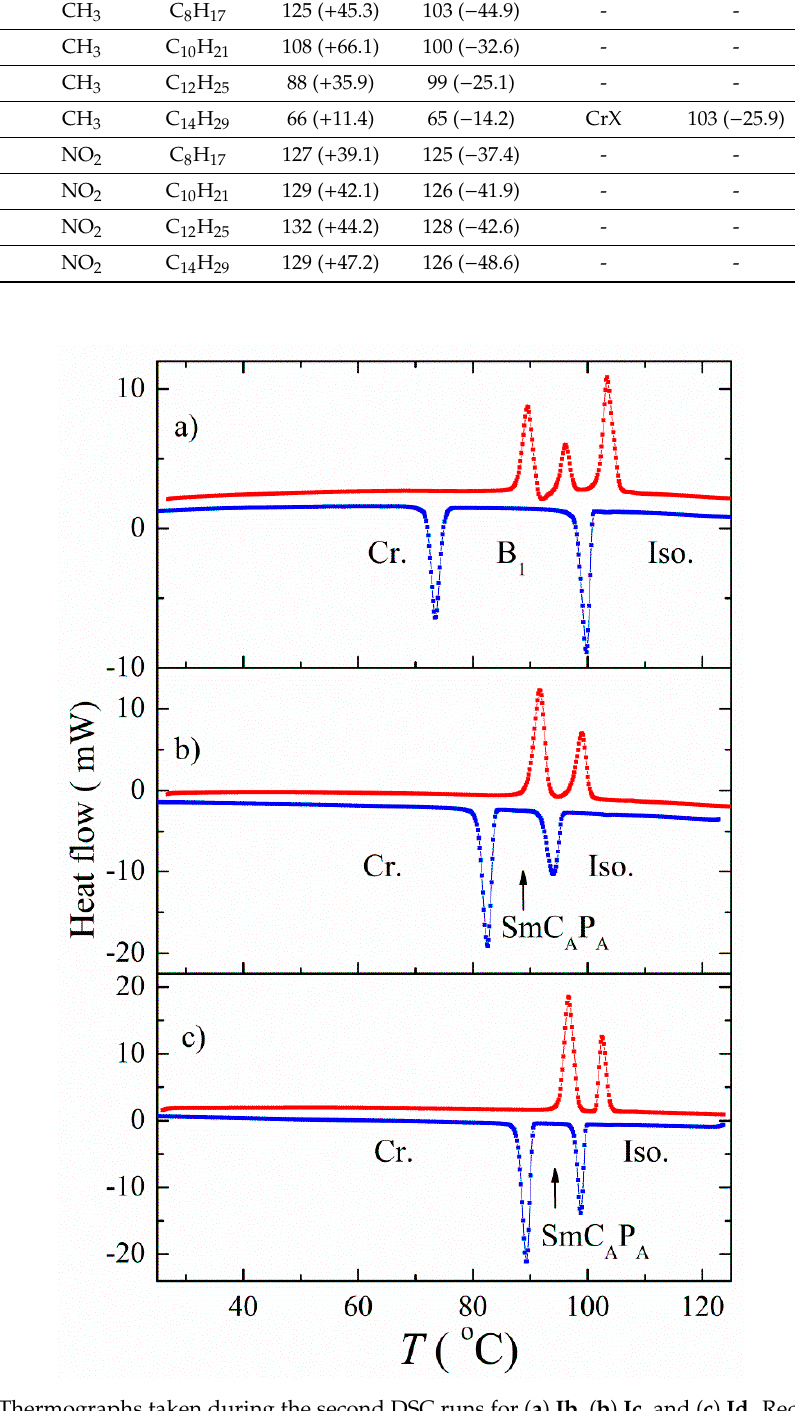
Figure 1. Thermographs taken during the second DSC runs for ( a ) Ib , ( b ) Ic , and ( c ) Id . Red colors are for the second heating and the blue color for the second cooling runs.